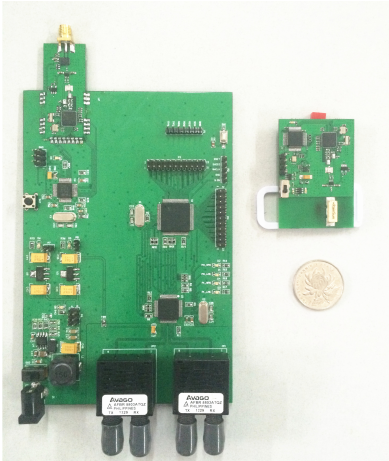
Figure 1. The prototypes of the BS and mobile positioning node (MN).